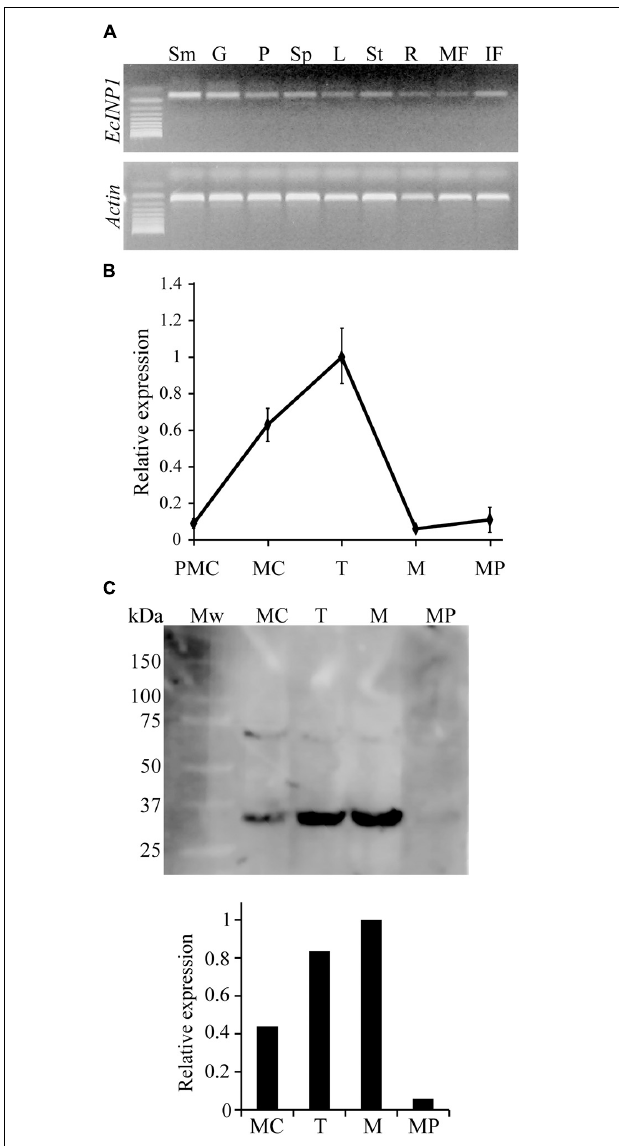
FIGURE 2 | Expression patterns of EcINP1 . (A) Expression analysis of EcINP1 , based on semi-quantitative RT-PCR, in different plant organs. Sm, stamen; G, gynoecium; P, petal; Sp, sepal; L, leaf; St, stem; R, root; MF, mature fruit; IF, immature fruit. (B) qRT-PCR-based expression analysis of EcINP1 in anthers at different pollen development stages. Actin was used as a normalization control. (C) Detection of EcINP1 protein levels by Western blot immunoassay in anthers at different pollen development stages. The bar plot shows the relative expression of EcINP1 (normalized to total proteins detected with a Stain-free technology gel as a loading control and quantified with the AlphaView software). PMC, pre-mother cell; MC, mother cell; T, tetrad; M, microspore; MP, mature pollen.